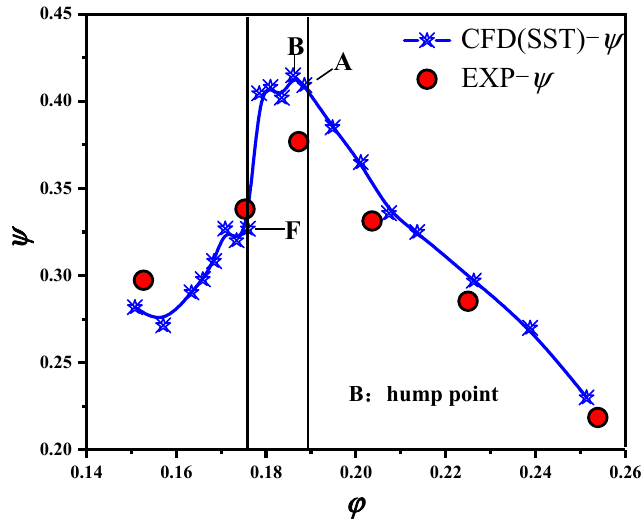
Figure 7. Performance curve of the axial flow fan.